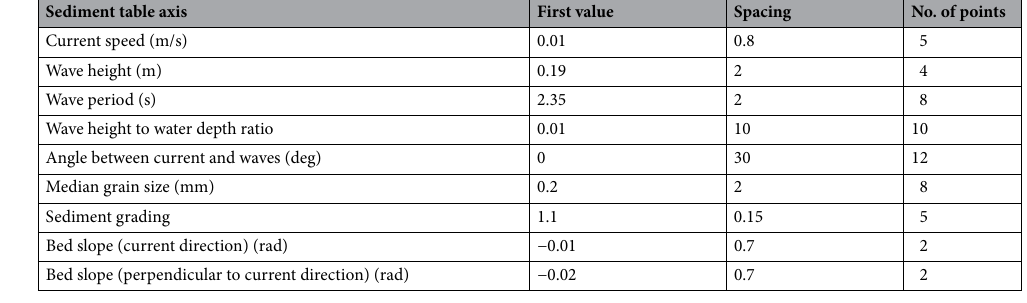
Table 4. Calibrated sediment transport table for shoreline evolution simulations. The first value, spacing, and the number of points in each axis define the range of each condition that may appear during a simulation and influence sediment transport rates. The first value is the minimum value. The second value in each axis, except grain size, is the “First value + Spacing” and so forth. The second value for grain size is the “First value × Spacing” and so on.